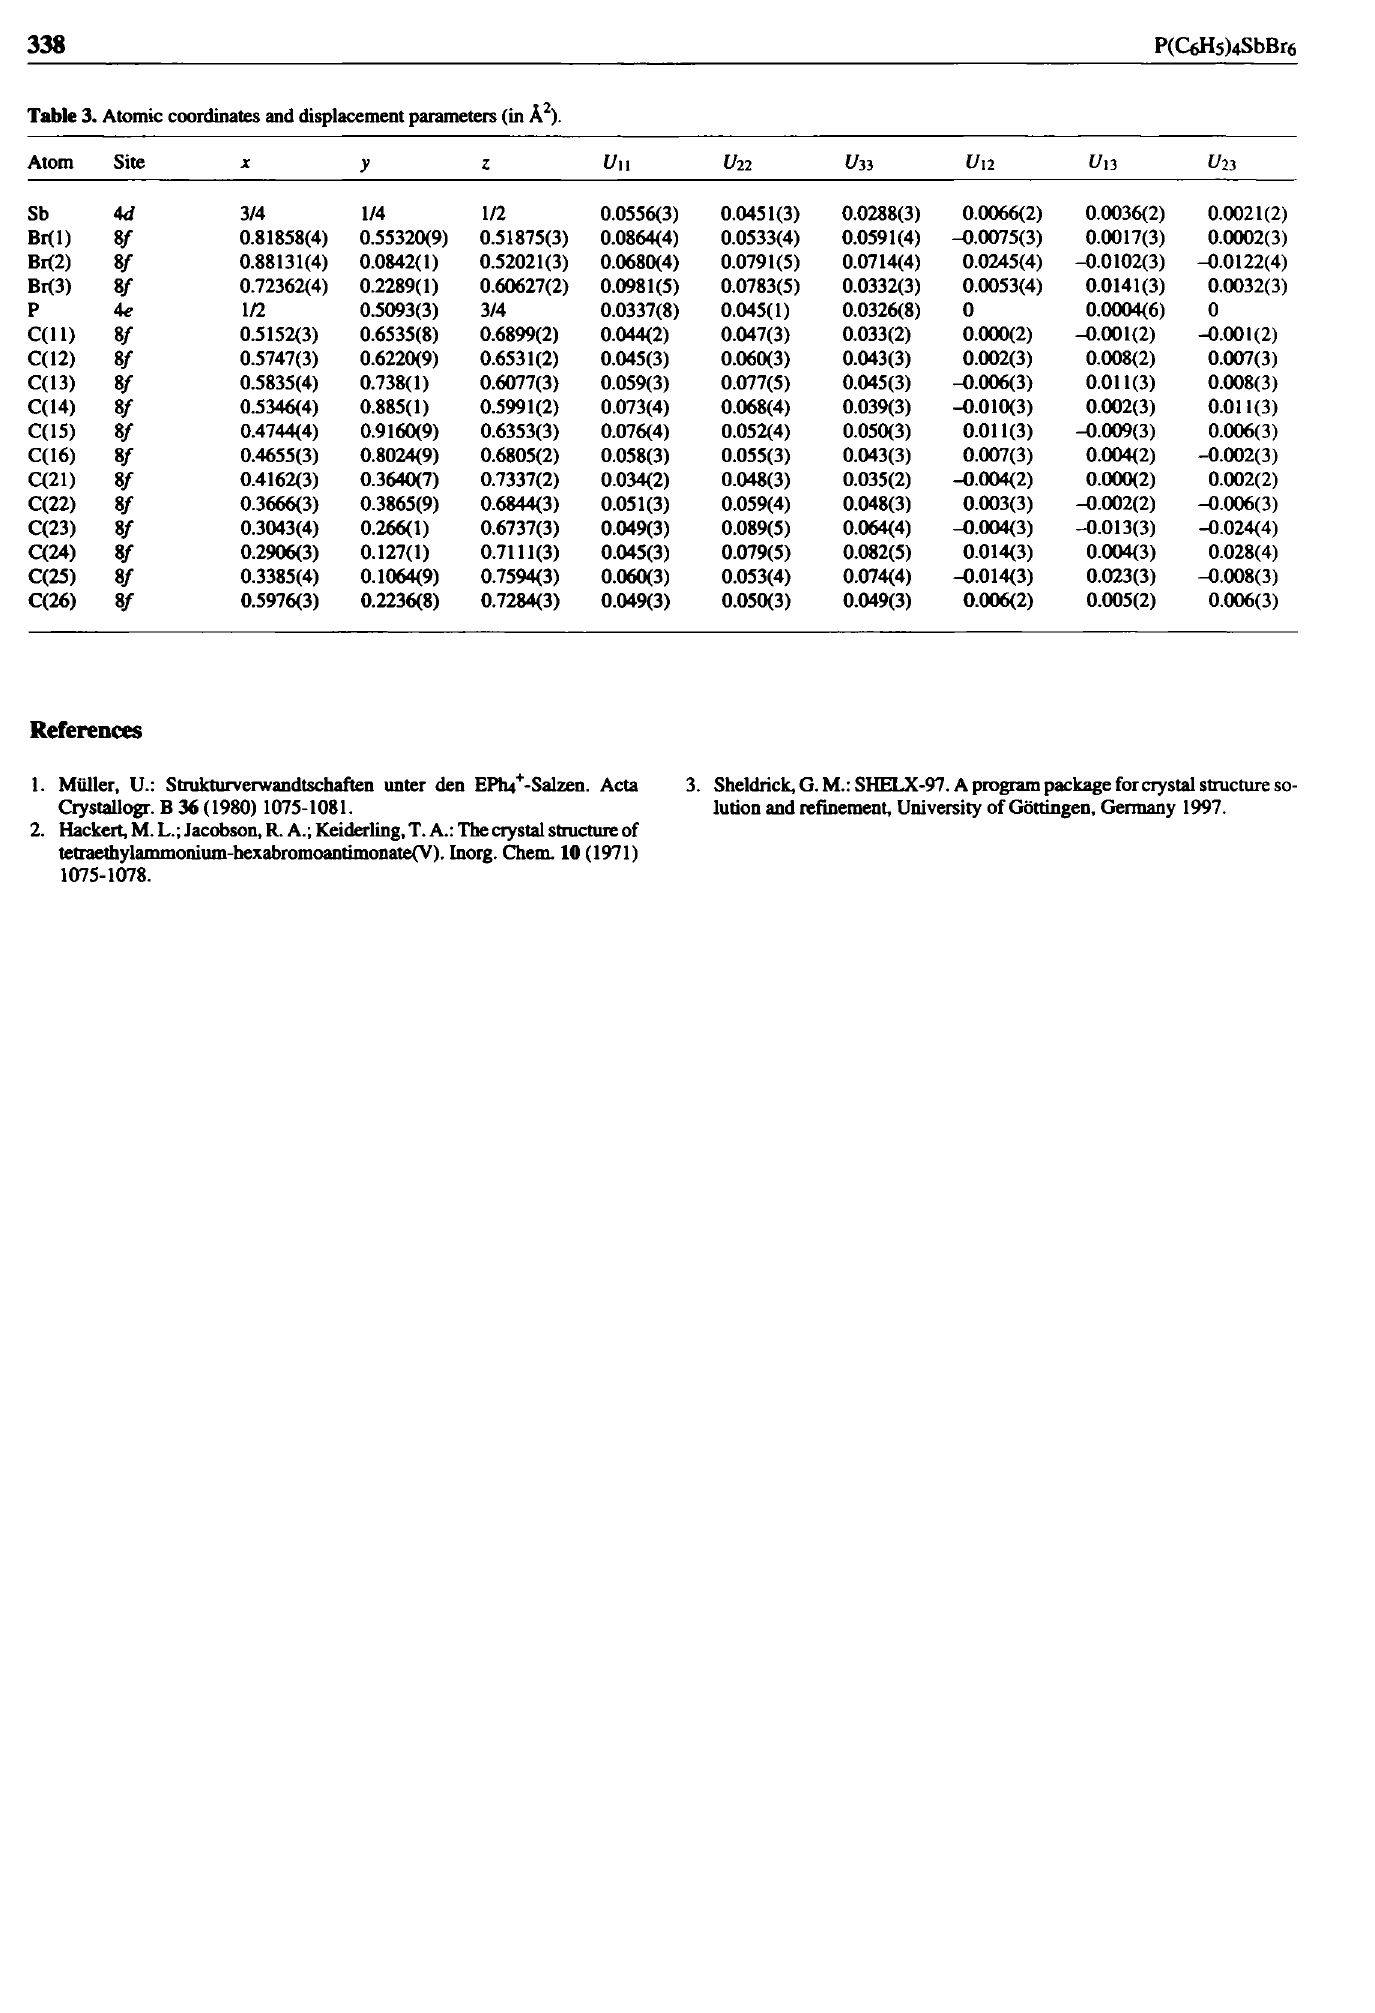
Table 3. Atomic coordinates and displacement parameters (in À 2